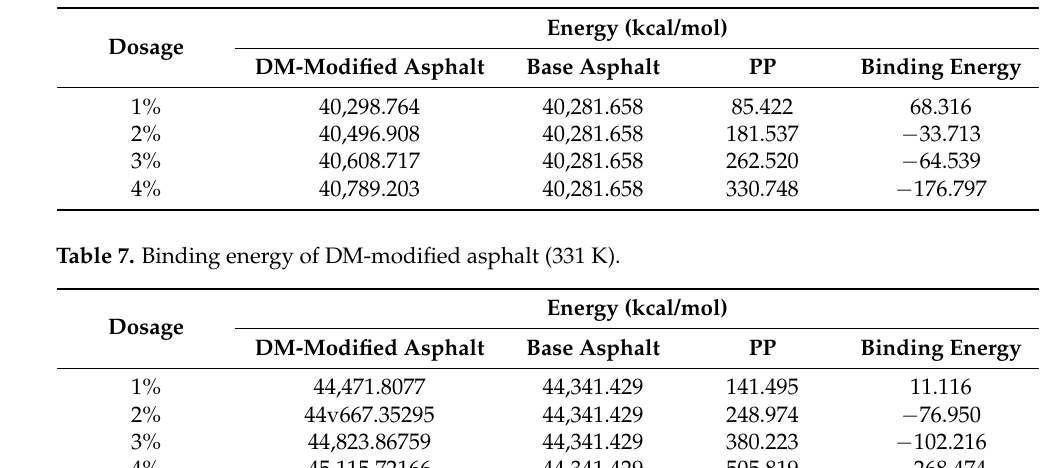
Table 6. Binding energy of DM-modified asphalt (298 K).